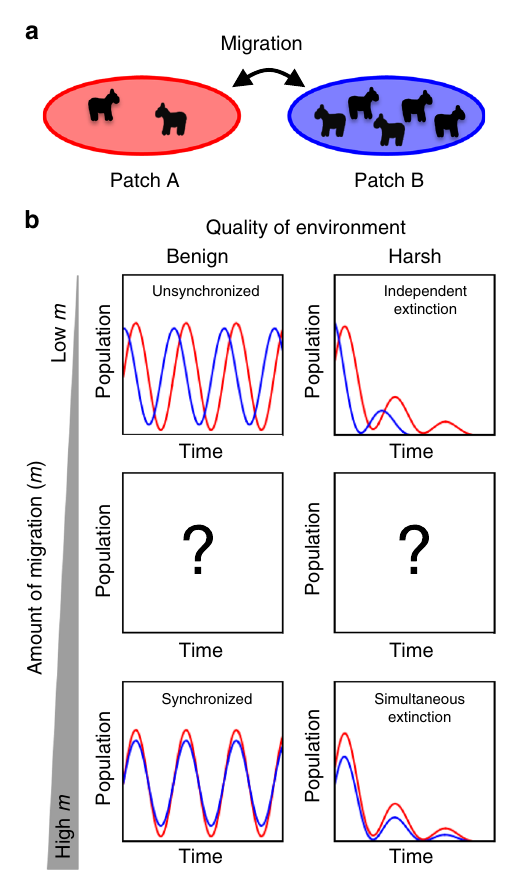
Fig. 1 The cartoon illustrates possible qualitative effects of migration on population dynamics of a species in benign as well as harsh environmental conditions. a The population dynamics of two patches can be coupled via migration. b Under benign conditions, low migration rates are insuf fi cient to couple population dynamics on the two patches (top left). On the other hand, high migration rates lead to synchronization, rendering the two patches equivalent (bottom left). An open question concerns how the population dynamics respond to intermediate migration rates (center left). In harsh conditions, population patches can become extinct (top right) and high migrations rate could lead to simultaneous extinction (bottom